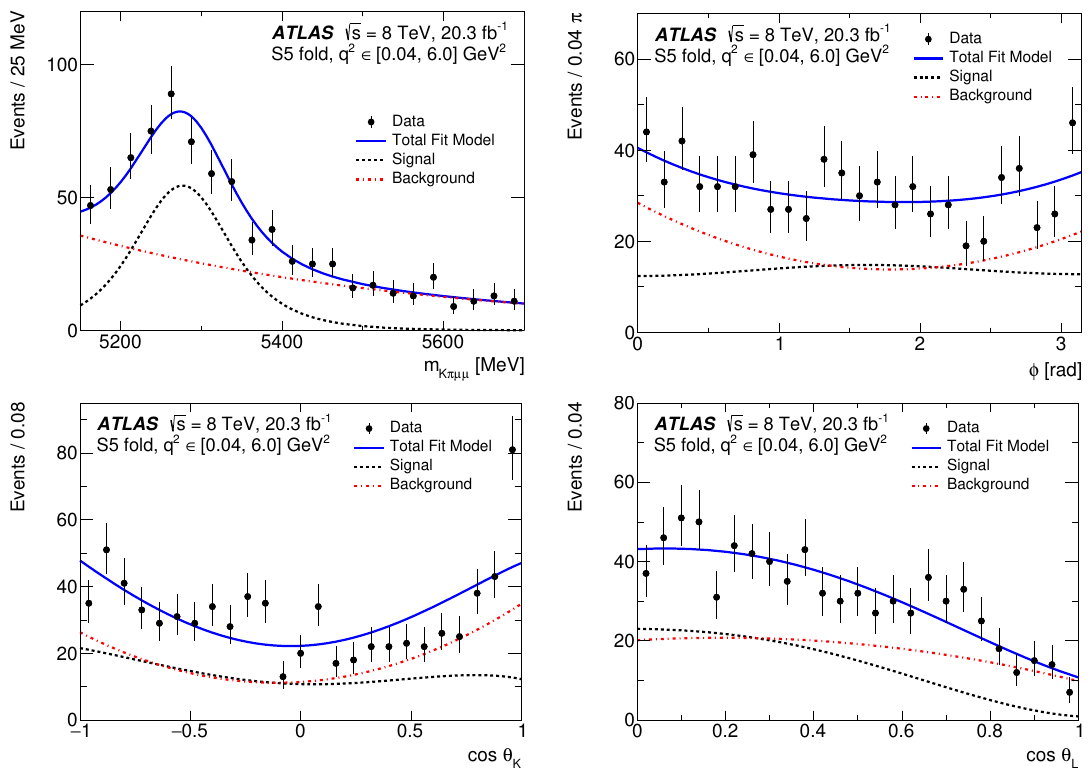
Figure 9 . The distributions of (top left) m , (top right) (cid:30) , (bottom left) cos (cid:18) , and (bottom K(cid:25)(cid:22)(cid:22) K right) cos (cid:18) obtained for q 2 2 [0 : 04 ; 6 : 0] GeV 2 . The (blue) solid line is a projection of the total L pdf, the (red) dot-dashed line represents the background, and the (black) dashed line represents the signal component. These plots are obtained from a (cid:12)t using the S folding 5